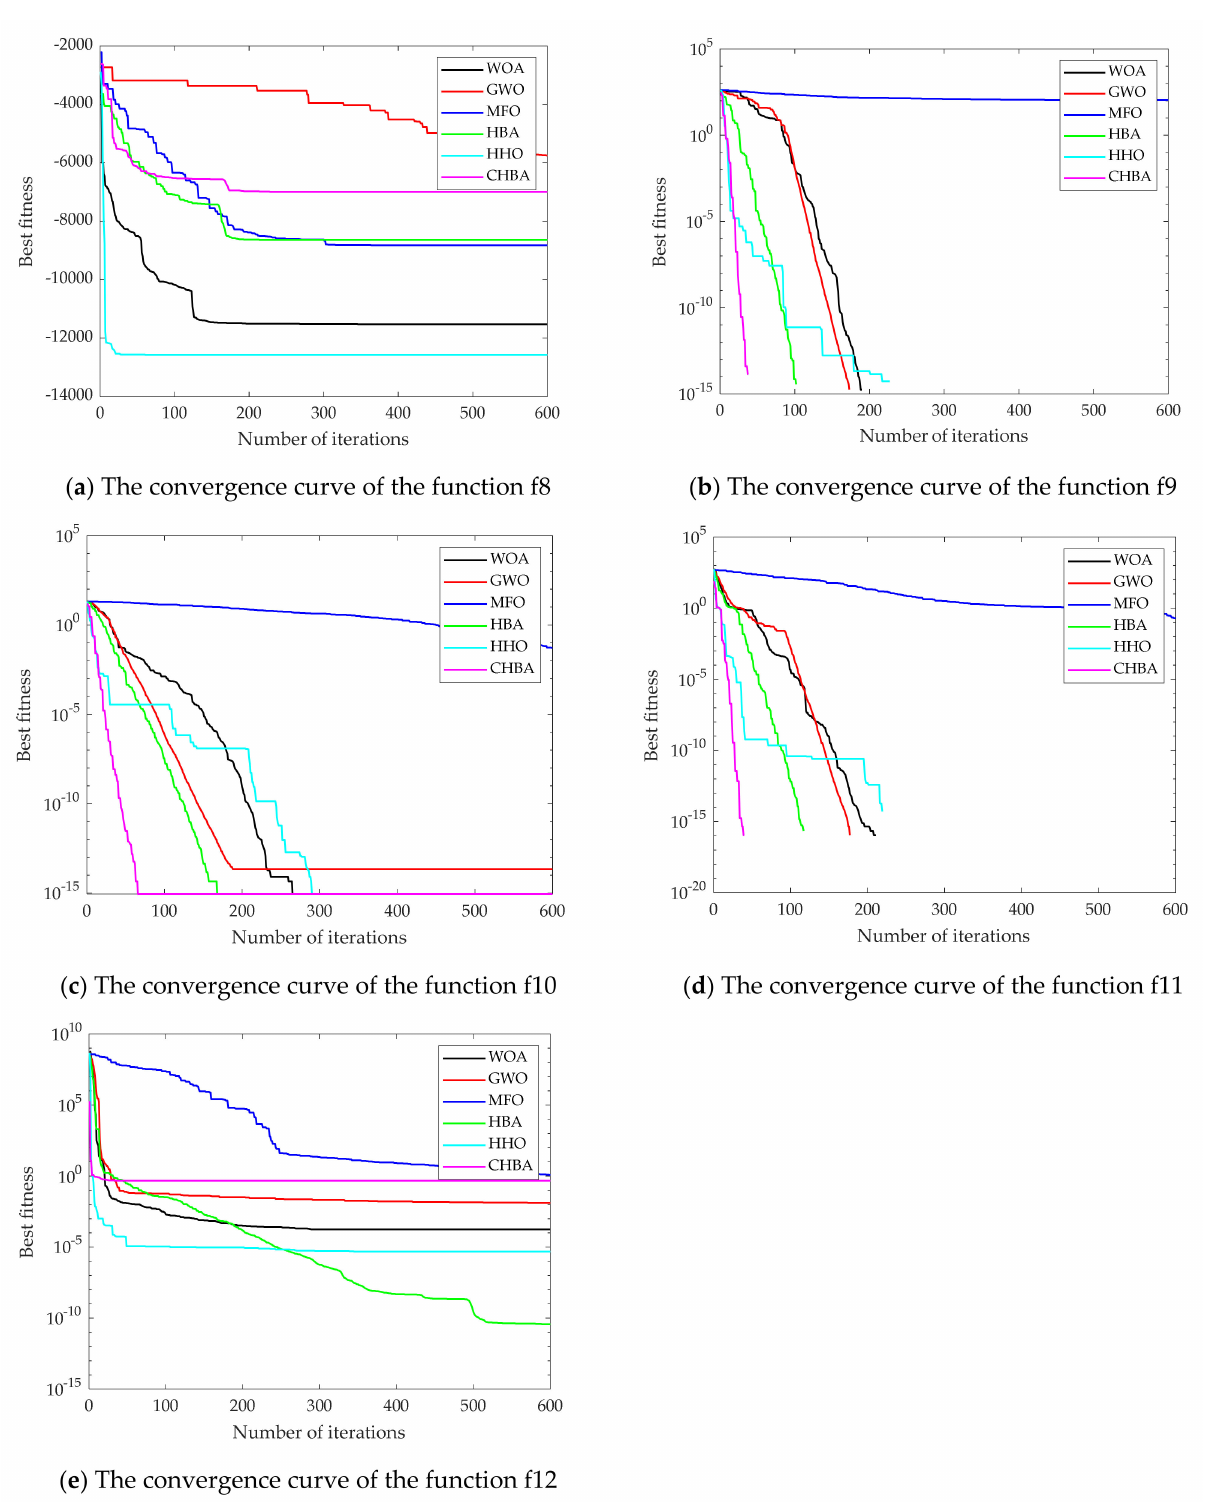
Figure 5. Convergence curve of high-dimensional single objective